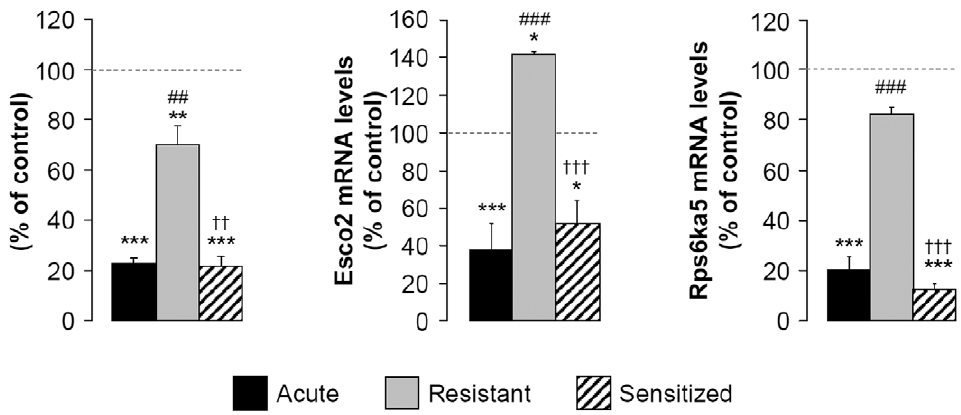
Figure 2. Expression of EIBS is associated with tolerance to the transcriptional effects of an ethanol challenge on epigenetic-related genes. During 10 days, mice received daily i.p. injections of saline or ethanol (2 g/kg) solution. At day 17, 30 min after saline or ethanol challenge (2 g/kg), striata were isolated to perform real-time PCR (n=4 per group). Means ( 6 SEM) of regulated genes expression are expressed as percentages of control * P , 0.05, ** P , 0.01, *** P , 0.001 vs control; ## P , 0.01, ### P , 0.001 vs acute; {{ P , 0.01, {{{ P , 0.001 vs resistant groups.